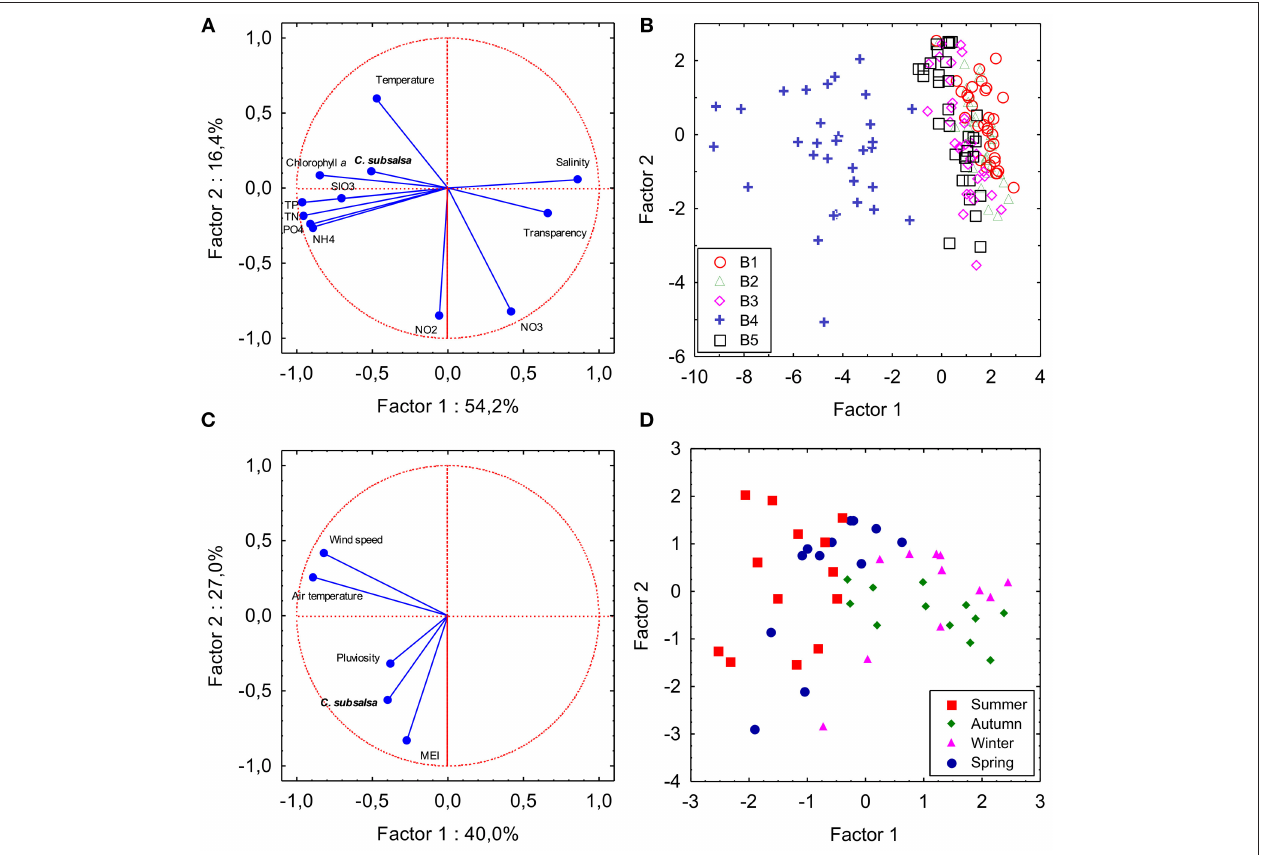
FIGURE 7 | Principal component analysis. Plots showing variables and samples plotted on the two first components axes. (A,B) PCA based on a correlation matrix of C. subsalsa cell concentration and water physical and chemical variables of 163 samples collected in five locations in Guanabara Bay (series B). SIO3: silicate; PO4: orthophosphate; NH4: ammonia; NO2: nitrite; NO3: nitrate; TP: total phosphorus; TN: total nitrogen. (C,D) PCA based on a correlation matrix of monthly C. subsalsa maximum cell concentration and climatological variables from February, 2014 to January, 2018. MEI: Multivariate El Niño Index. Sampling season is indicated in the samples coordinates